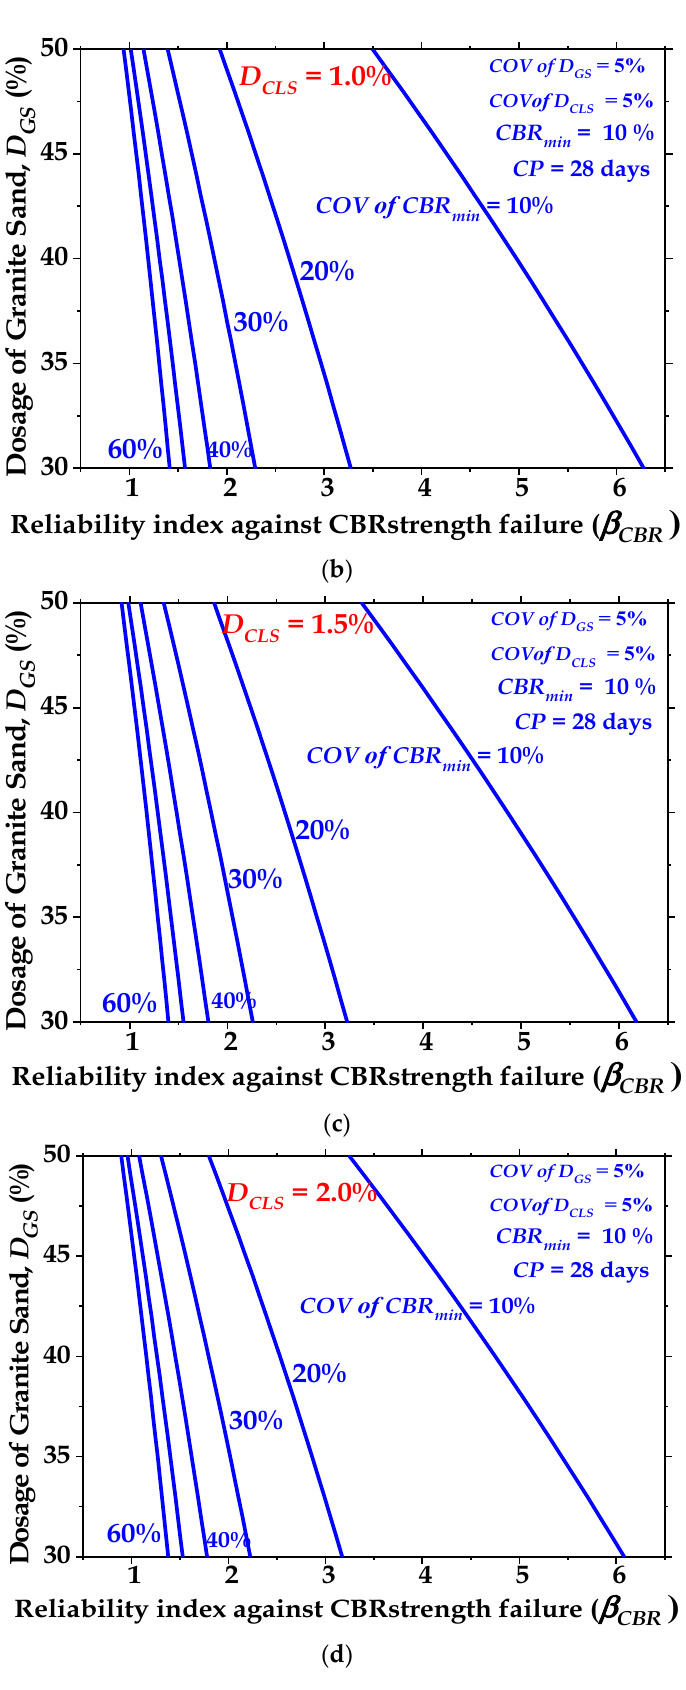
Figure 17. ( a ) Optimal values of dosages of granite sand (D GS ) for various values of reliability index against CBR strength failure ( β CBR ) for 28-day-cured treated clayey soils when D CLS =